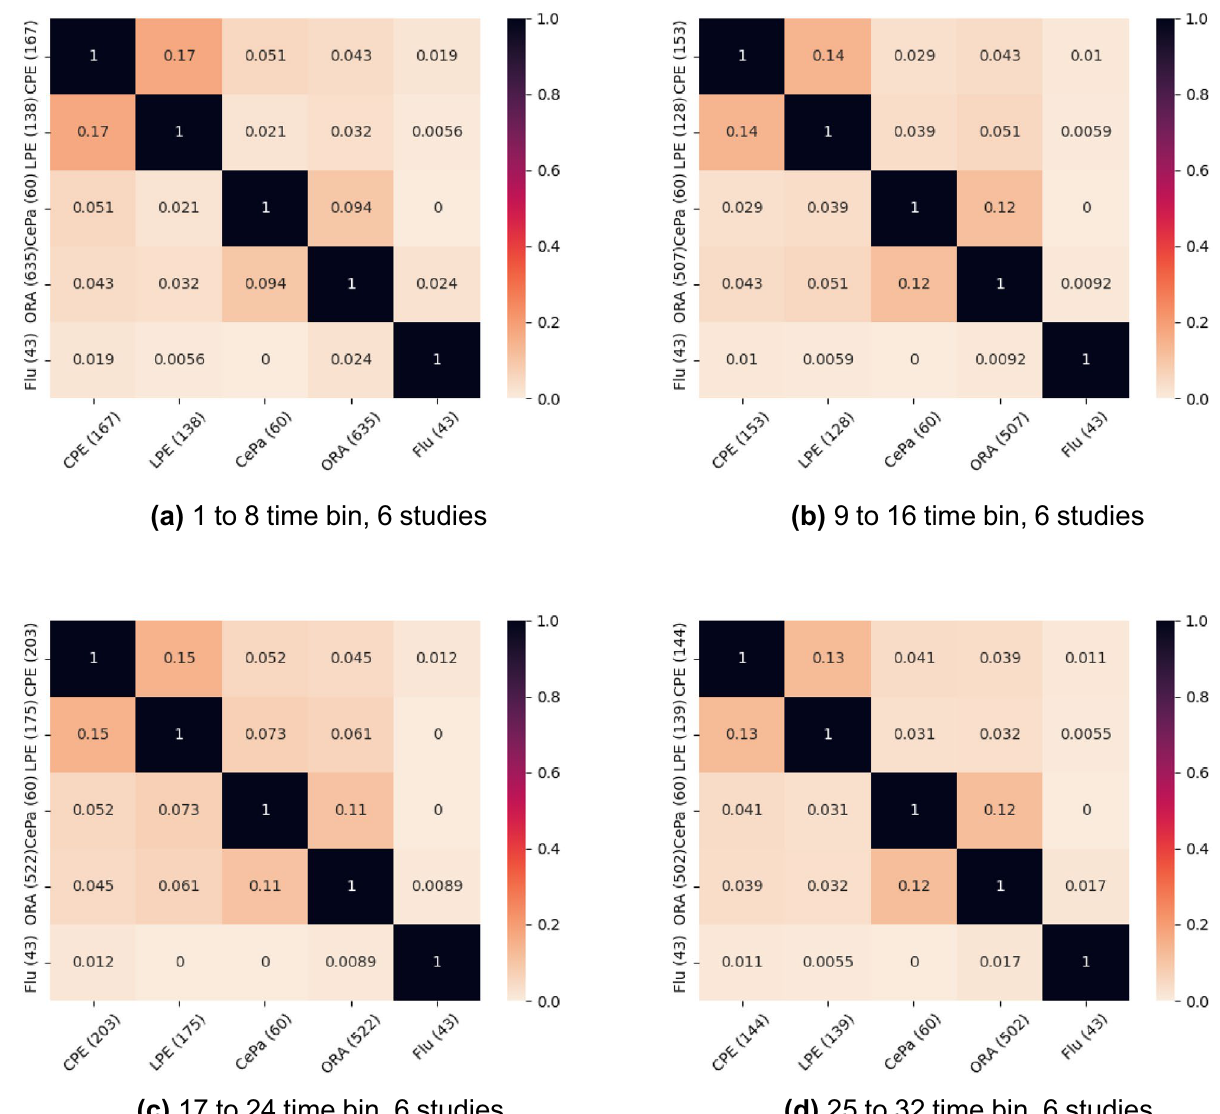
Figure 2. Jaccard overlap between the selected pathways for different methodologies. Pathways are selected using the 6 training studies. Each plot is for a different train/test experiment with LIMMA using subject identifier. The CPE configuration is pre-computed, directed edges with PageRank